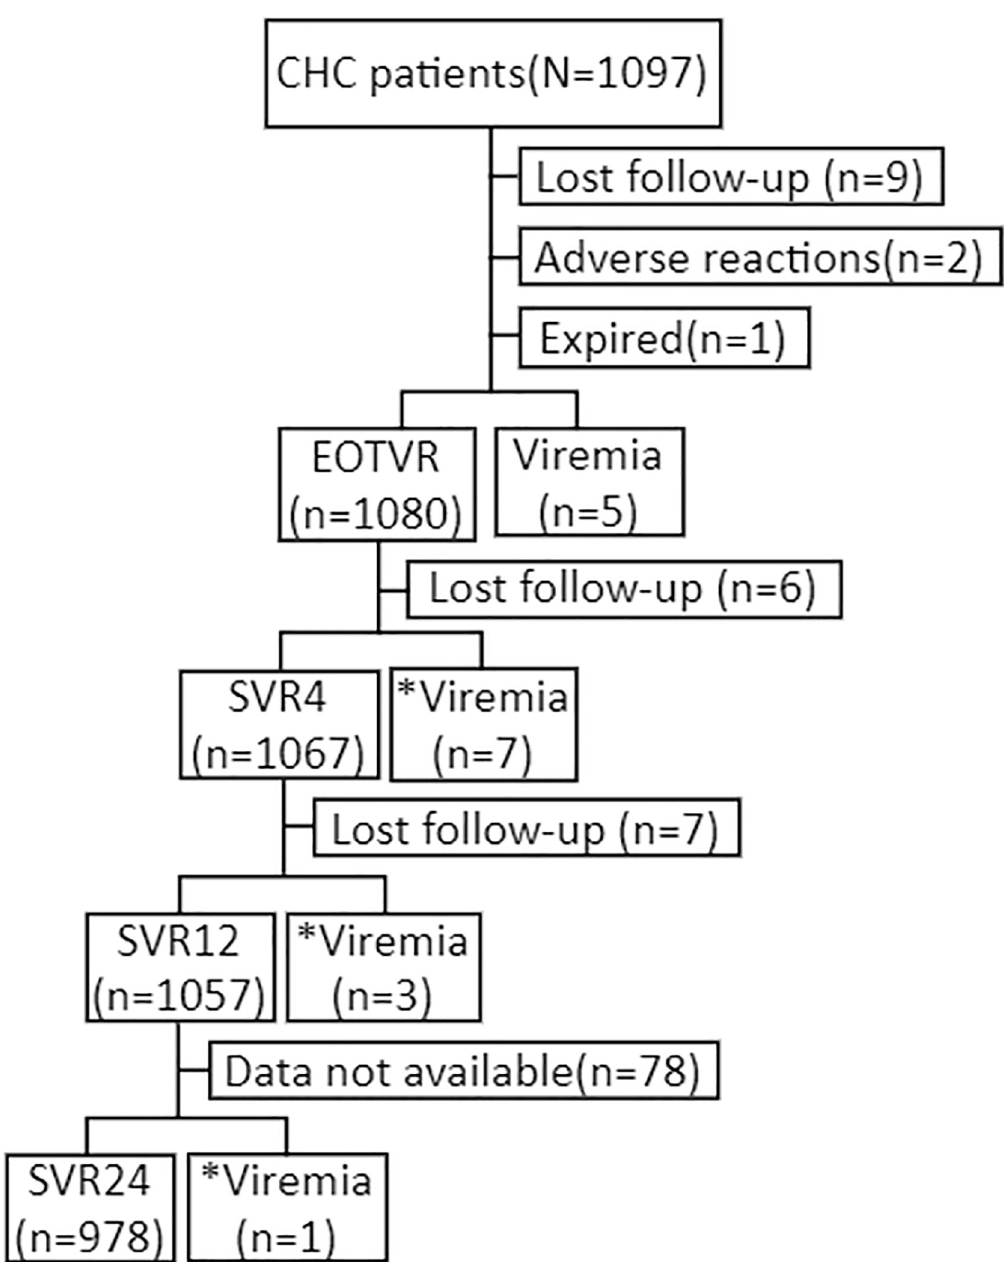
Fig 1. Study flowchart. Abbreviations: CHC: chronic hepatitis C. EOTVR: end-of-treatment virological response. � Viremia represents patients who experienced virological reappearance after EOT. The characteristics and serial viral kinetics of the eleven patients who encountered HCV RNA reappearance after EOT are listed in Table 2. Among them, six (54.5%) were infected with HCV genotype 2 and received a sofosbuvir-plus-ribavirin regimen. Nine patients (81.8%) had liver cirrhosis. All HCV genotypes at the time of RNA reappearance were the same as the pretreatment genotypes. A 72-year-old cirrhotic female patient (Case 11) who had RNA reap- pearance at SVR24 also had the same HCV genotype, HCV-1b, before and after DAA